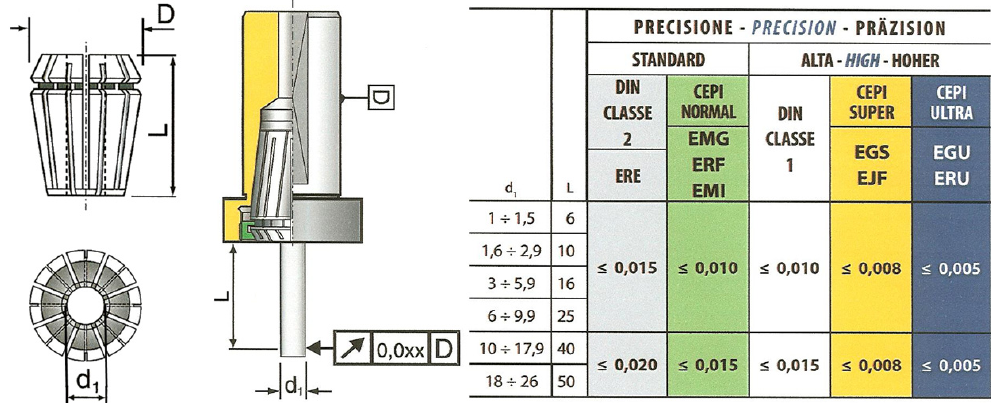
Figure 2: Grips: a) geometry; b) dimension as DIN6499 standard (all the measure are in millimeter). CEPI Catalog. Material data